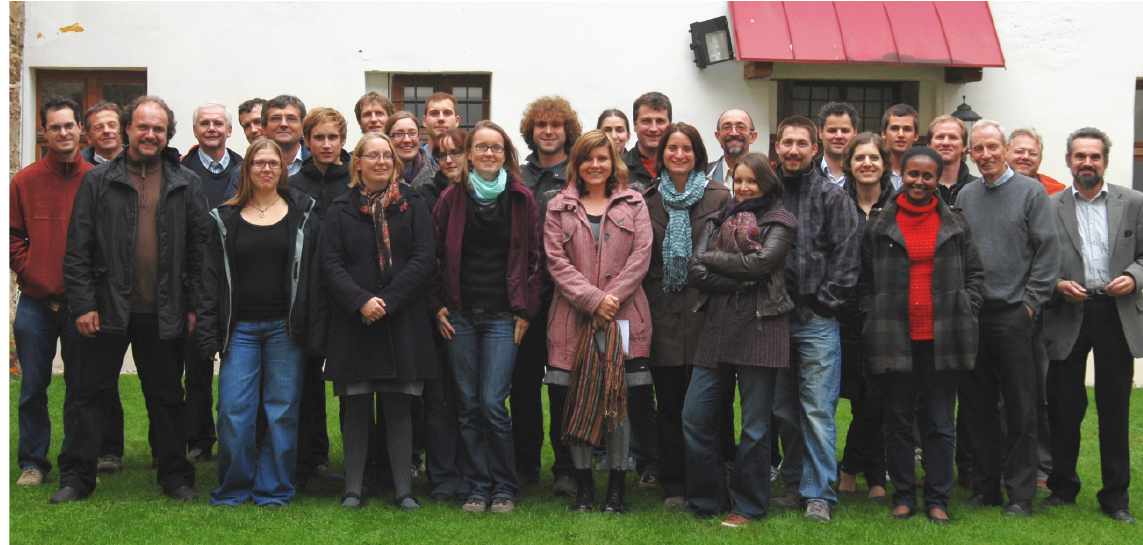
Fig. 7. Students and faculty of the Vienna Doctoral Programme on Water Resource